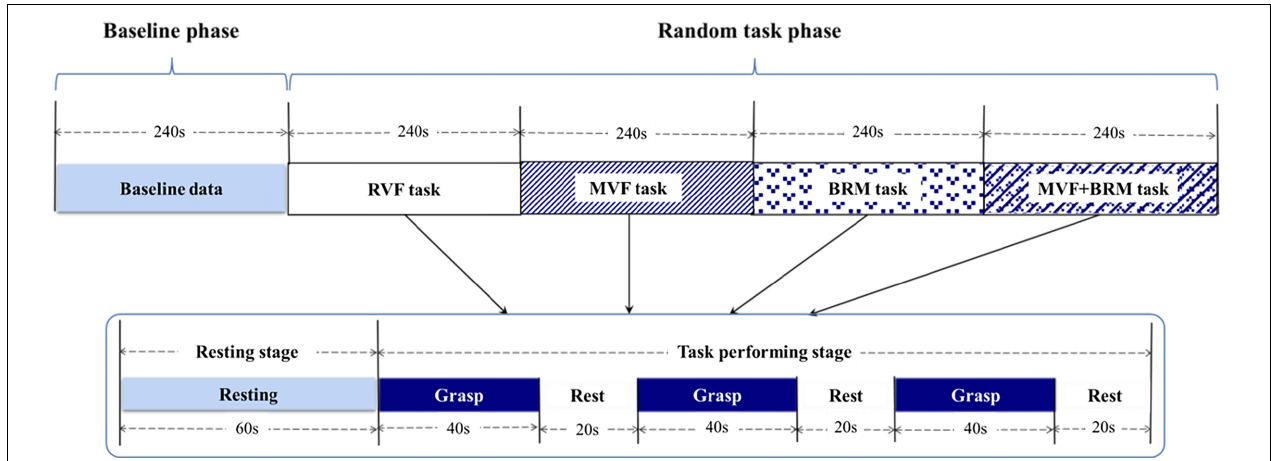
FIGURE 3 | fNIRS testing procedure including baseline phase and visual feedback task phase. The order of four tasks were randomized. Each visual feedback task consists of three trials. RVF task, real visual feedback task; MVF task, mirror visual feedback task; BRM task, bilateral robotic movement task; MVF + BRM task, Mirror visual feedback combined with bilateral robotic movement